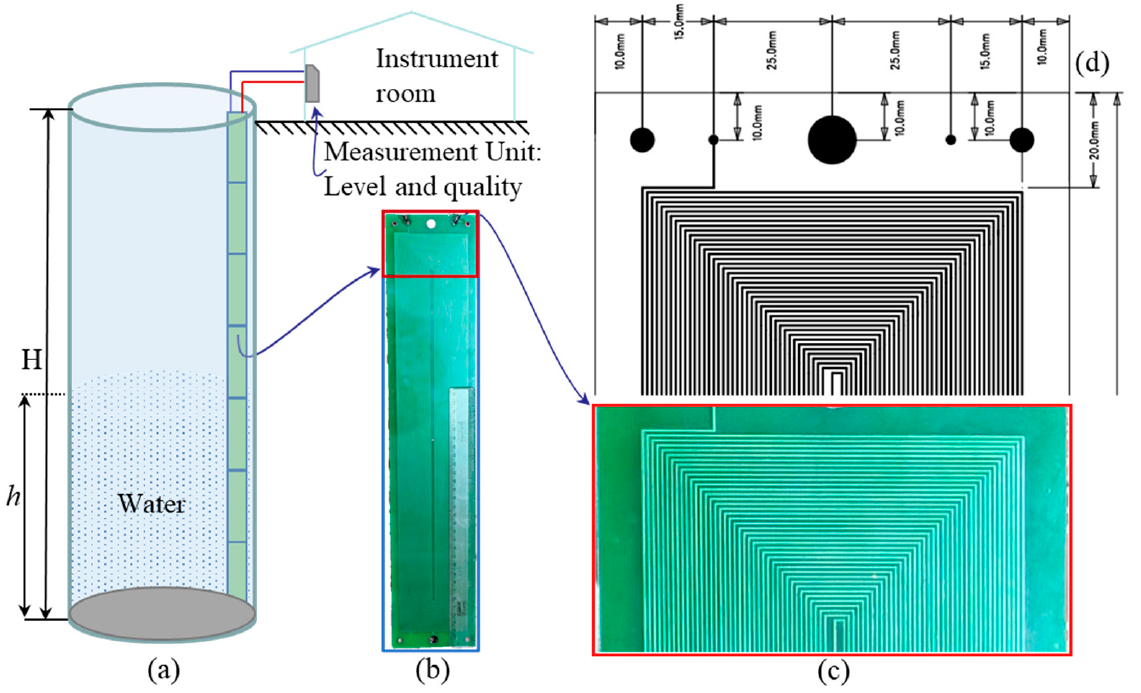
Figure 2. Proposed inductive–capacitive level sensor and the details of the fabricated sensor coil used for testing. It is a scalable, modular design; multiple units of PCBs with coil as shown can be connected in series and mechanically appended, as shown in ( a ), to extend the range of level to be sensed. ( b ) Prototype CB with coil, ( c ) close-in view of the PCB, and ( d ) important dimensions of the